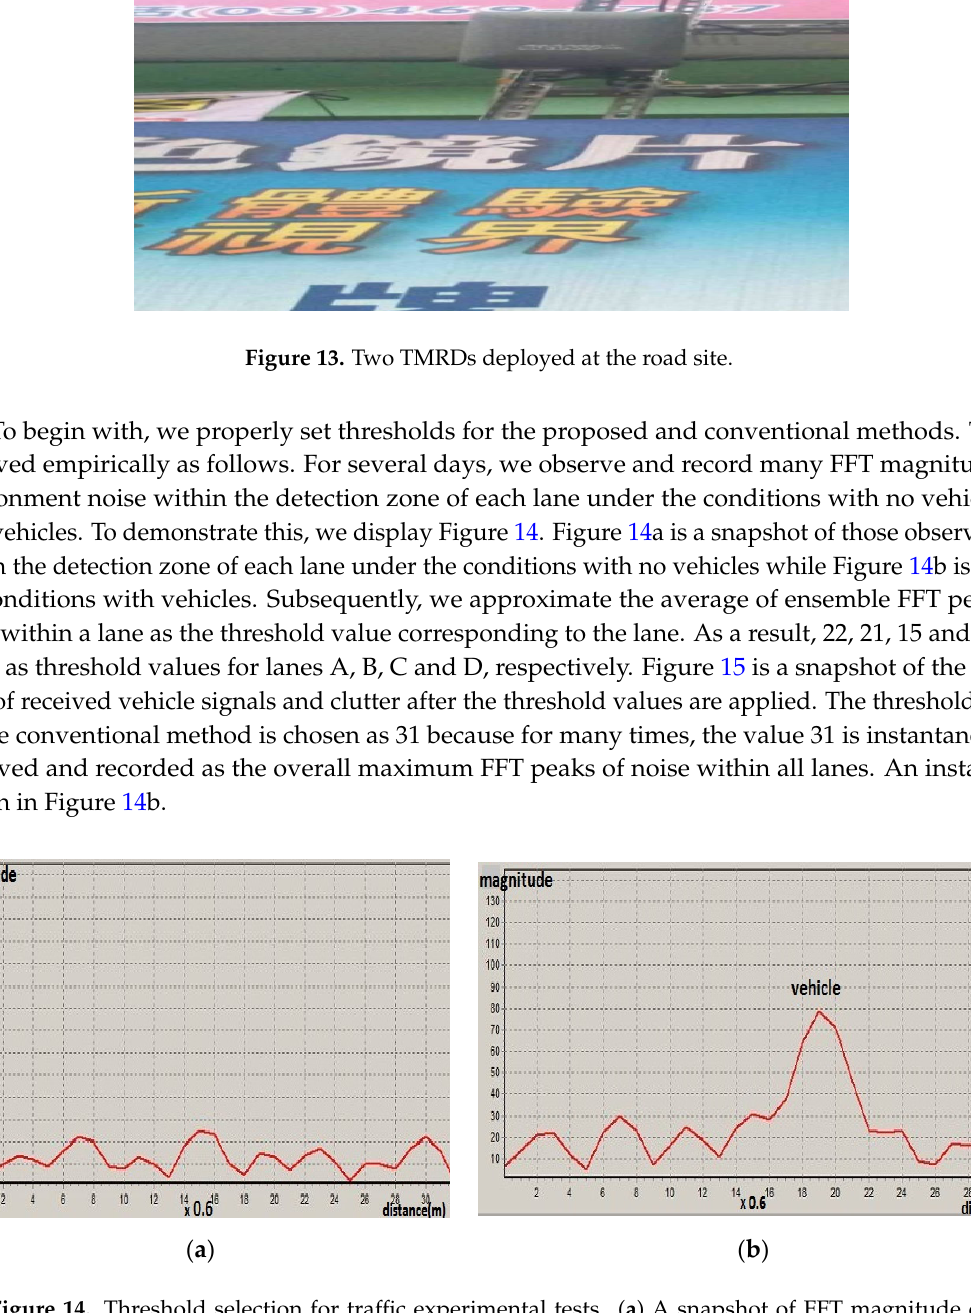
Figure 14. Threshold selection for traffic experimental tests. ( a ) A snapshot of FFT magnitude of environment noise within each lane with no vehicles; ( b ) A snapshot of FFT magnitudes of both environment noise and vehicle signal within each lane.